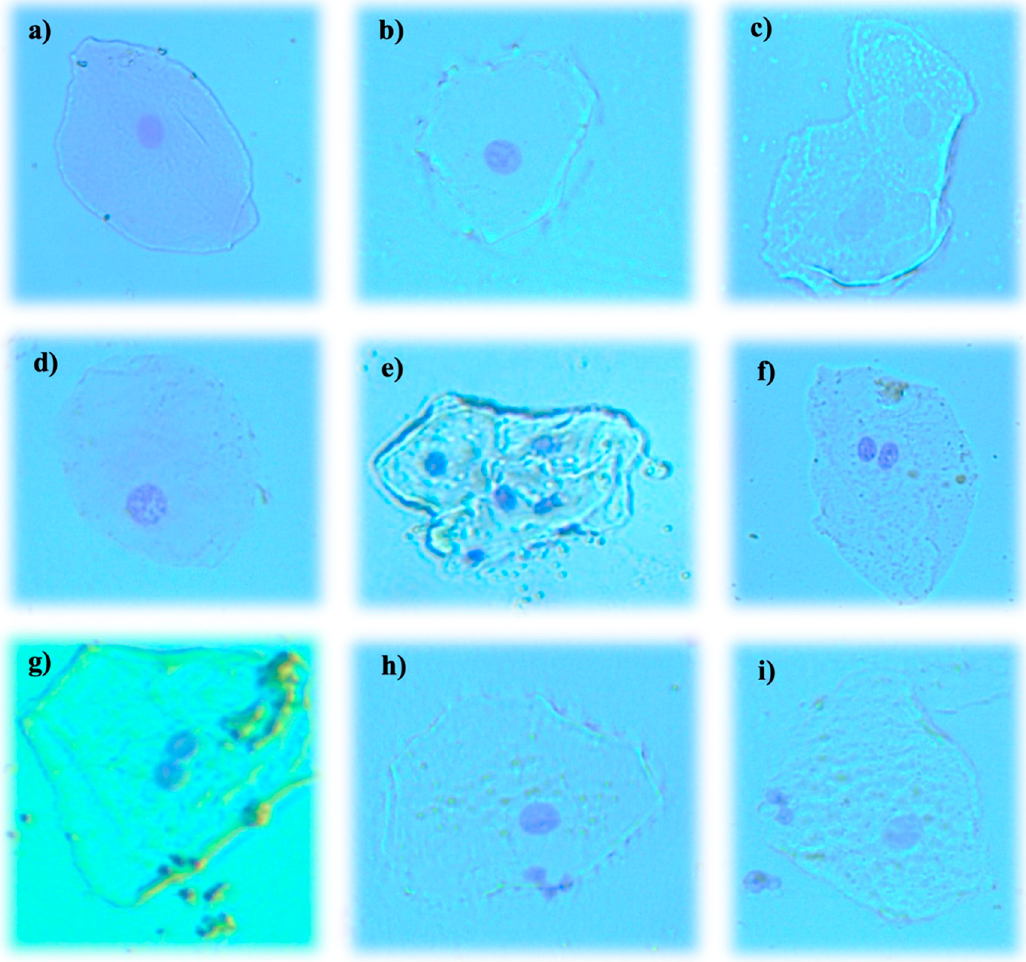
Figure 3. Cells with degenerative nuclear changes related to genotoxic damage of the FC group: ( a ) normal cells; ( b ) condensed chromatin (CC); ( c ) karyolysis (KL); ( d ) karyorrhexis (KR); ( e ) pyknotic nuclei (PY); ( f ) binucleated cells (BN); ( g ) lobulated nuclei (BUD); ( h , i ) cells with micronuclei (MN).